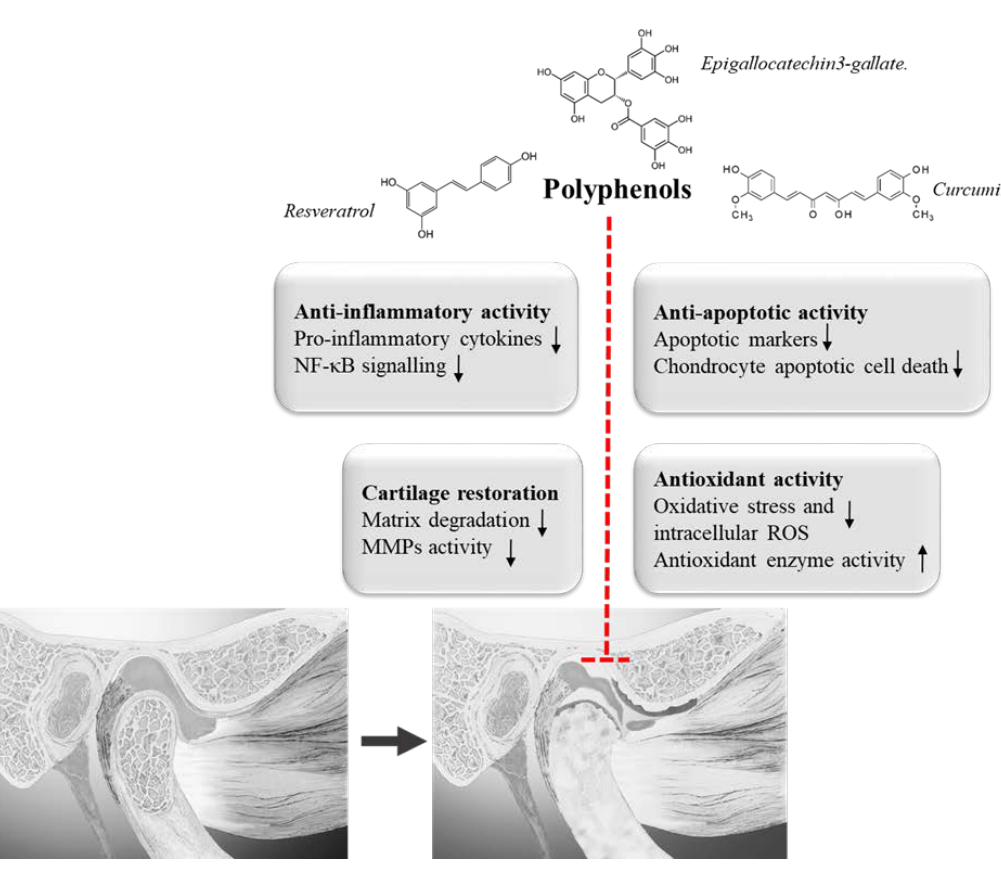
Figure 2. Suggested mechanisms triggered by polyphenols in the prevention of temporomandibular disorders (TMD).